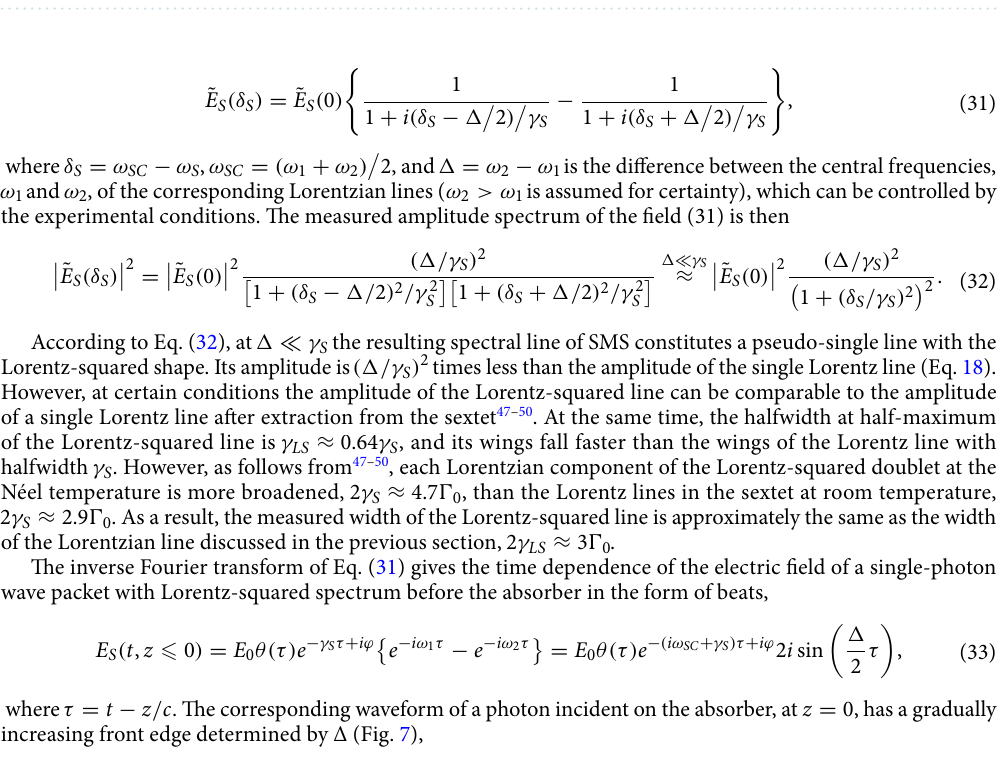
0 (in blue), = out ( t ) 4.7 0.4 γ S , has a width γ S γ 21 = = 3 γ 21 , like the Lorentz line in Fig. ≈